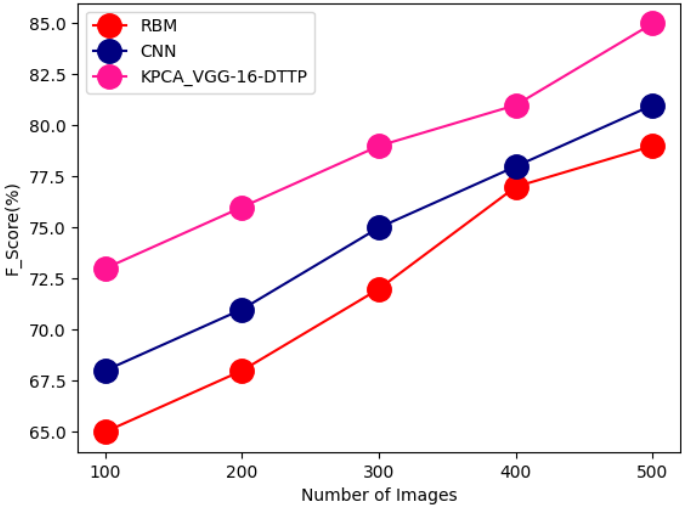
Figure 3. Comparison of F-score.